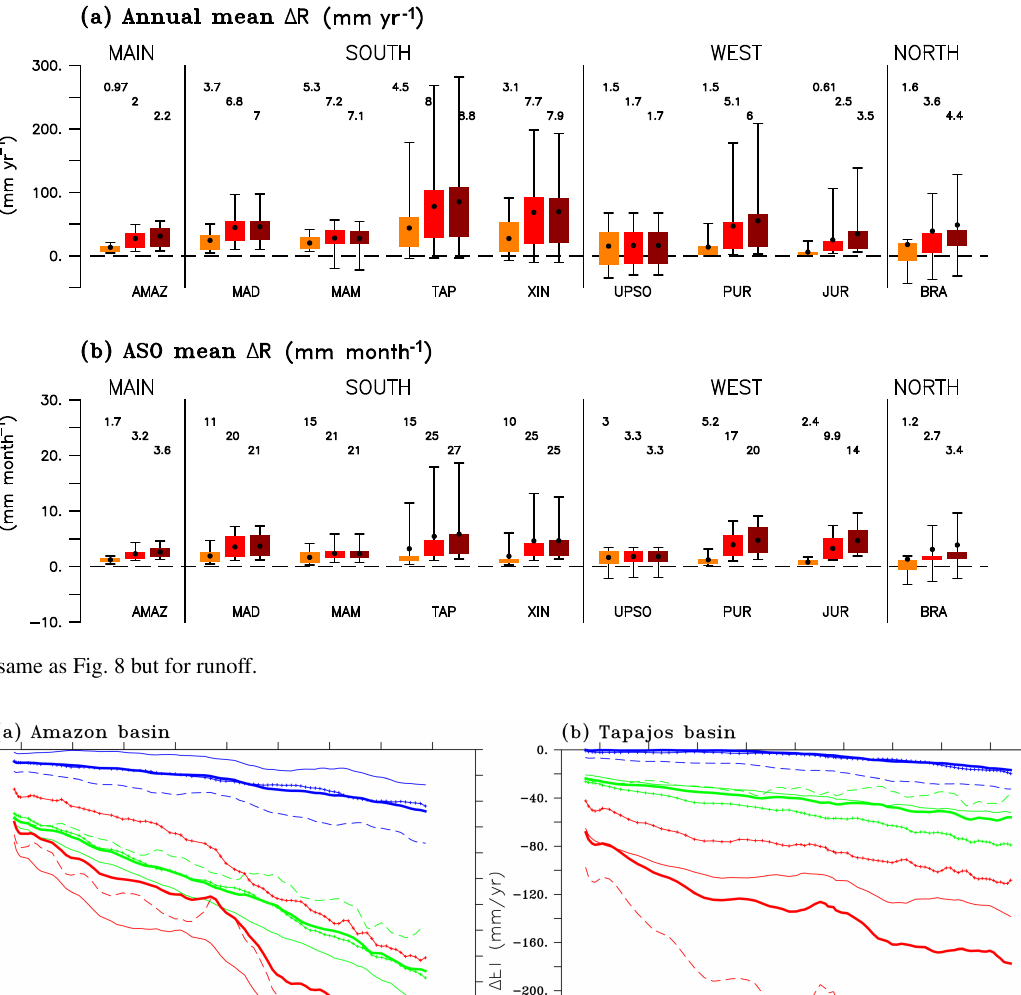
Figure 10. ET changes (mmyr − 1 ) over 2009–2100 (1-year running mean) as a function of tree area decrease (10 6 km 2 ) from scenario EXDEF within the (a) Amazon and (b) Tapajós